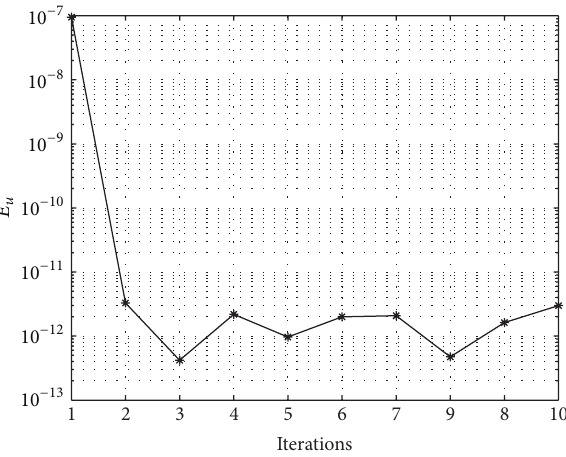
Figure 17: Modified KdV-Burger equation convergence graph.